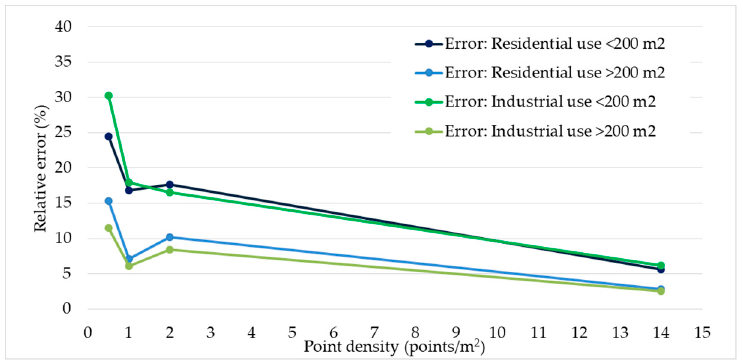
Figure 13. Mean relative error (%) in the rooftop area calculated for the different the point cloud densities depending on the use of the building and the area of the roof.